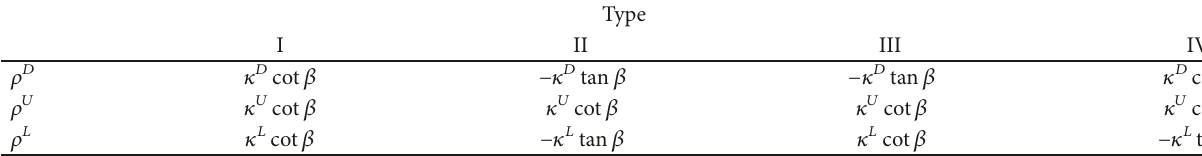
Table 1: Different types of 2HDM in terms of the Higgs boson couplings with 𝑈 (up-type quarks), 𝐷 (down-type quarks), and 𝐿 (leptons).